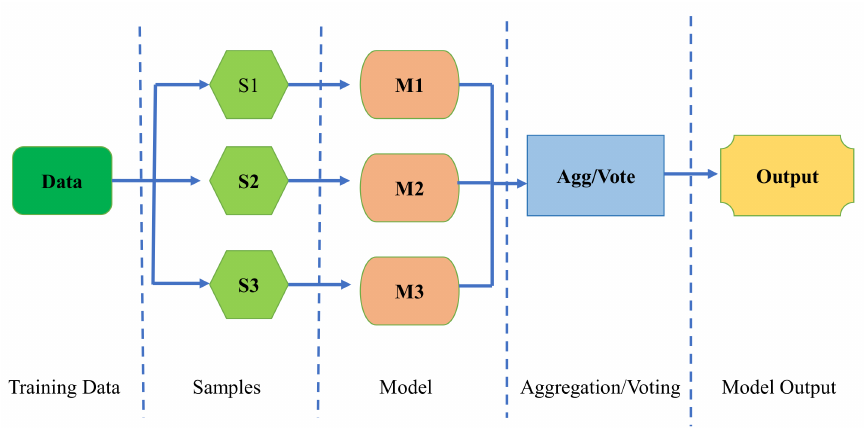
Figure 5. Flow chart of the bagging algorithm indicating the execution